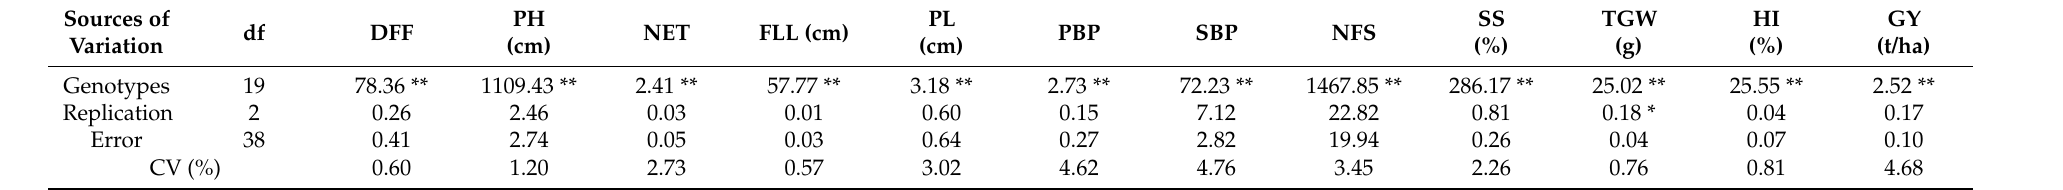
Table 1. Analysis of variance (mean sum of squares) for yield and its component characters in 20 T. Aman rice genotypes.